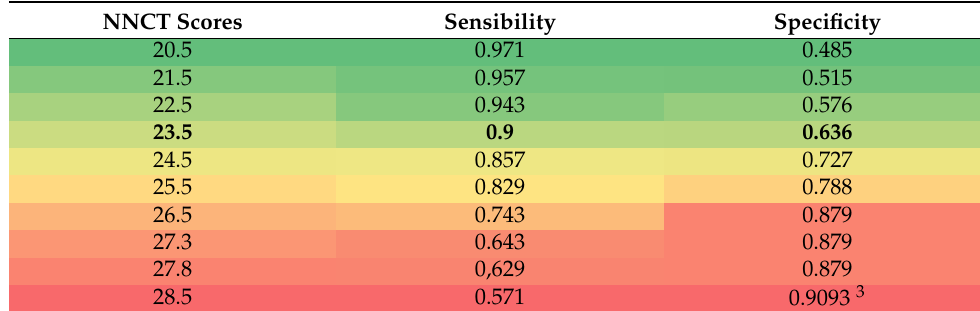
Table 3. Healthy older adults and AD dementia.